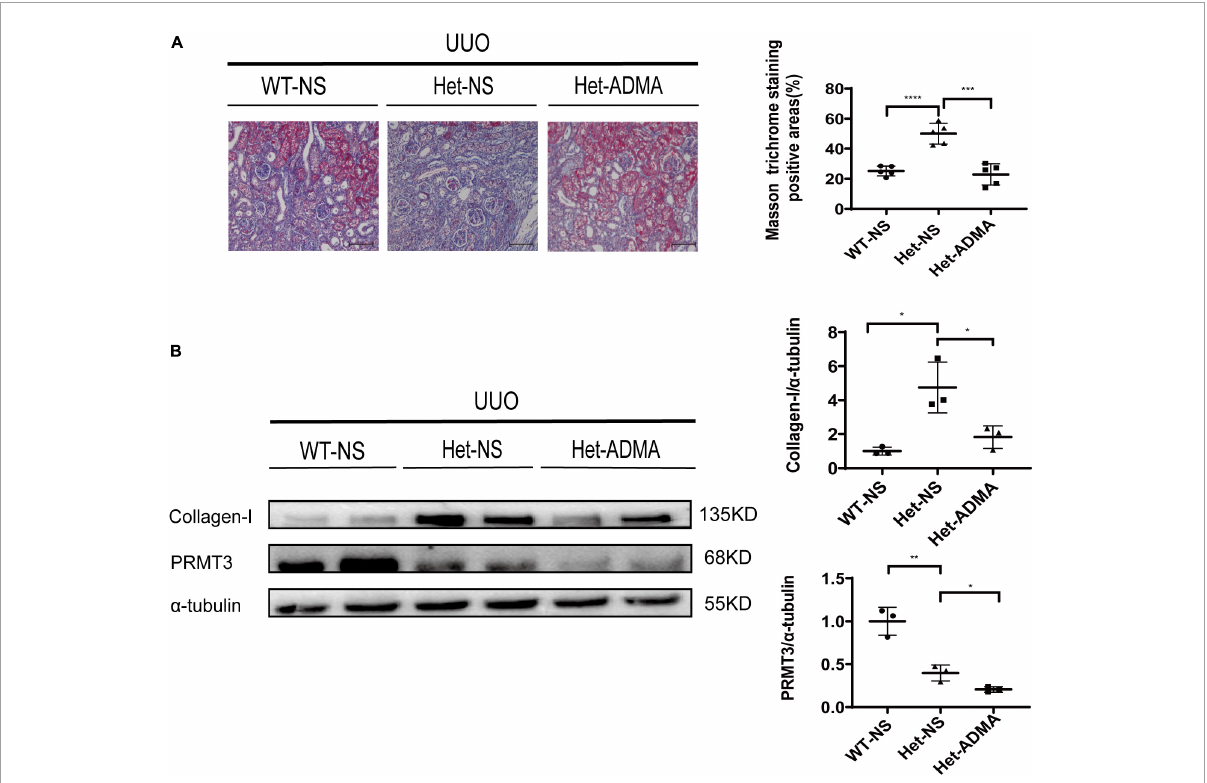
FIGURE3 Asymmetric dimethylarginine mitigates fibrosis in Prmt3 deleted UUO kidneys. WT or heterozygous (Het) Prmt3 mutant c57 mice received sham or UUO operation and were sacrificed at day 7 ( n = 7, WT-NS; n = 9, Het-NS; n = 8, Het-ADMA). Renal injection of normal saline (NS) or ADMA was performed during UUO operation. (A) Renal fibrosis was assessed by Masson’s trichrome staining ( n = 5 mice per group). Bars, 100 µ m. (B) The expression of collagen-I and PRMT3 were analyzed by Western blotting. Data represent mean ± SD. One-way ANOVA was used and comparison between two groups was performed by unpaired student t -test. * P < 0.05; ** P < 0.01; *** P < 0.001; **** P < 0.0001. One representative result of at least three independent experiments is